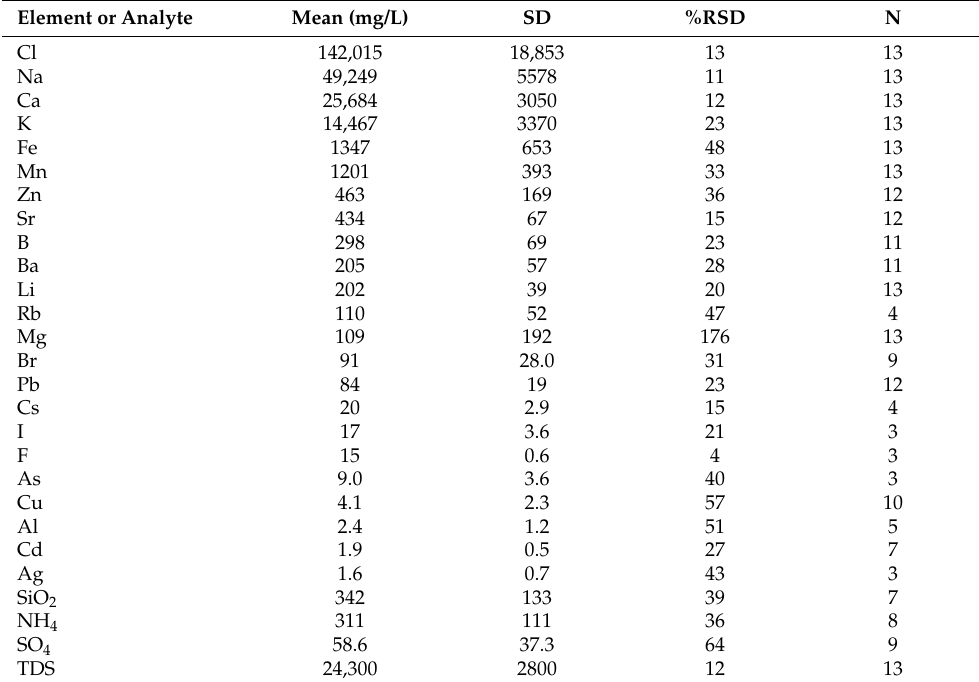
Figure 7. Distribution of geothermal brine samples with measured Li concentrations [23,24]. Geothermal brines are expected to be a significant source of domestic lithium production in the future. Table 2. Salton Sea geothermal brine chemical composition. Average calculated values reported in the literature representing post-flash geothermal brines [27,28,29,30,31,32,33,34,35].